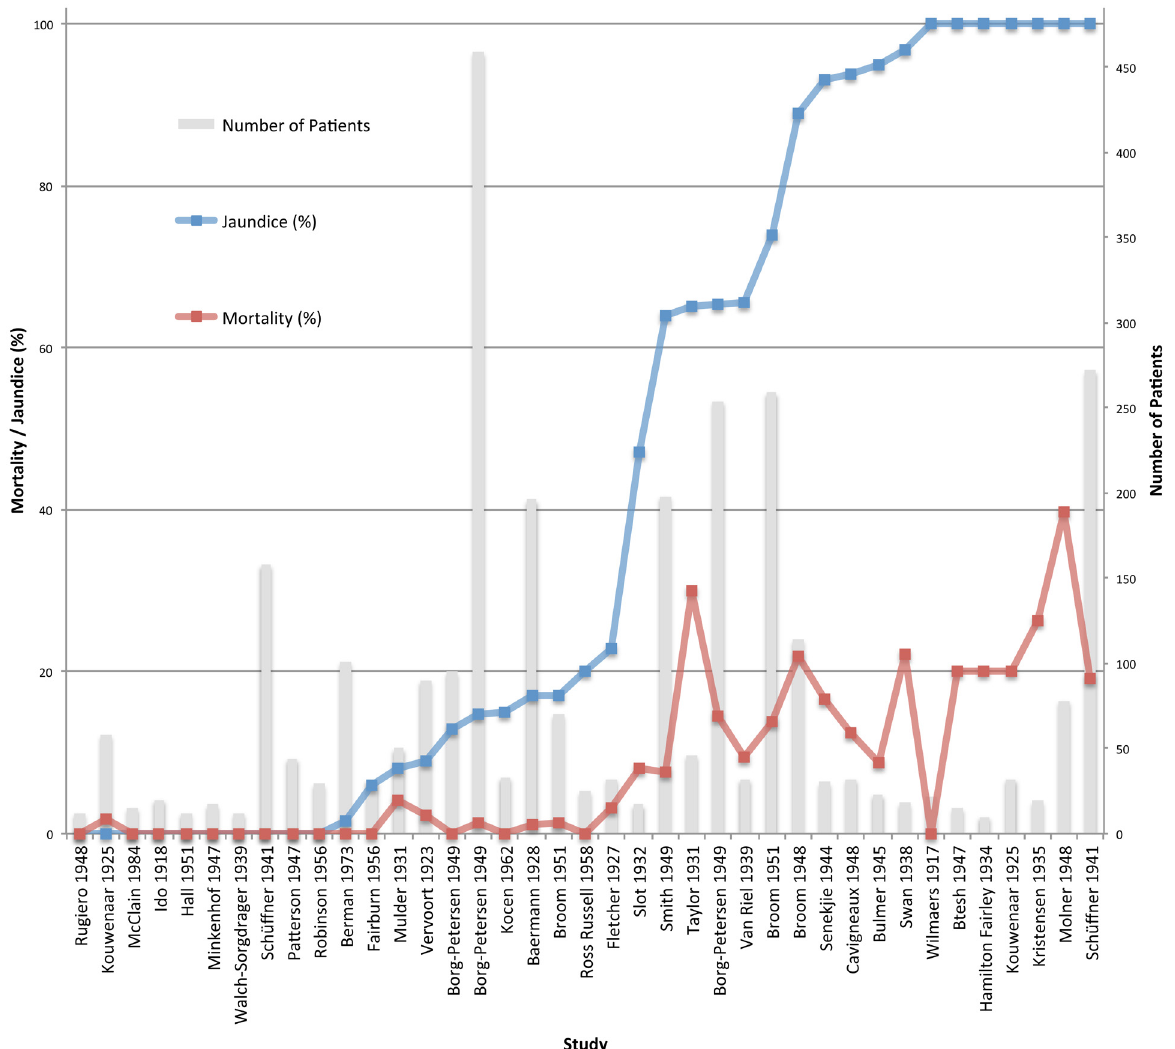
Fig 4. Mortality (red line) and number of patients (grey bar) by increasing frequency of jaundice (blue